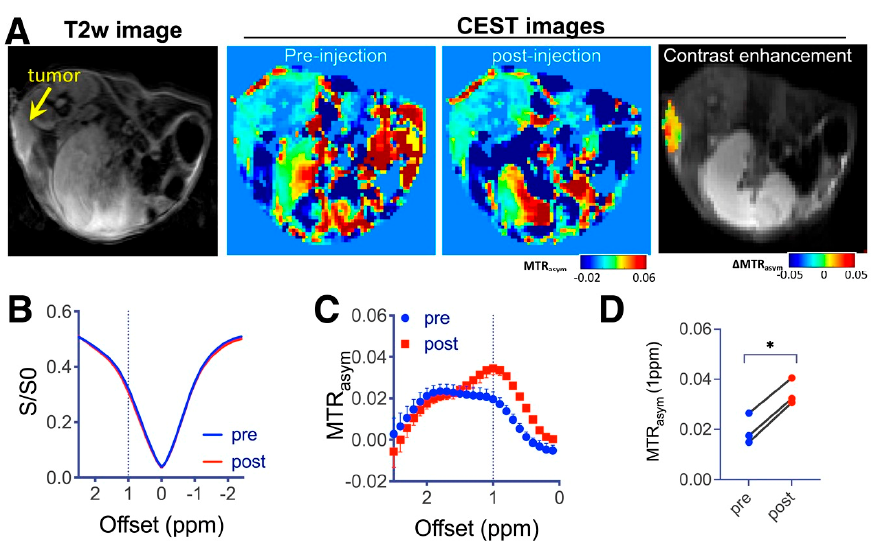
Figure 6. CEST MRI of CT26 tumors in mice receiving co-administration of LNT-SeNPs and TNF- α . ( A ) T2w image (left), CEST contrast images pre and 1 h post injection of LNT-SeNPs and TNF- α (middle) as quantified by MTR asym at 1 ppm, and an overlay image showing the CEST contrast enhancement in the tumor region on the top of T2w image of a representative mouse. ( B ) Mean Z-spectra and ( C ) mean MTR asym plots of three tumor ROI values. ( D ) Scatter plot of the mean tumor ROI values before and after LNT-SeNPs/TNF- α injection (* p = 0.05, n = 3).